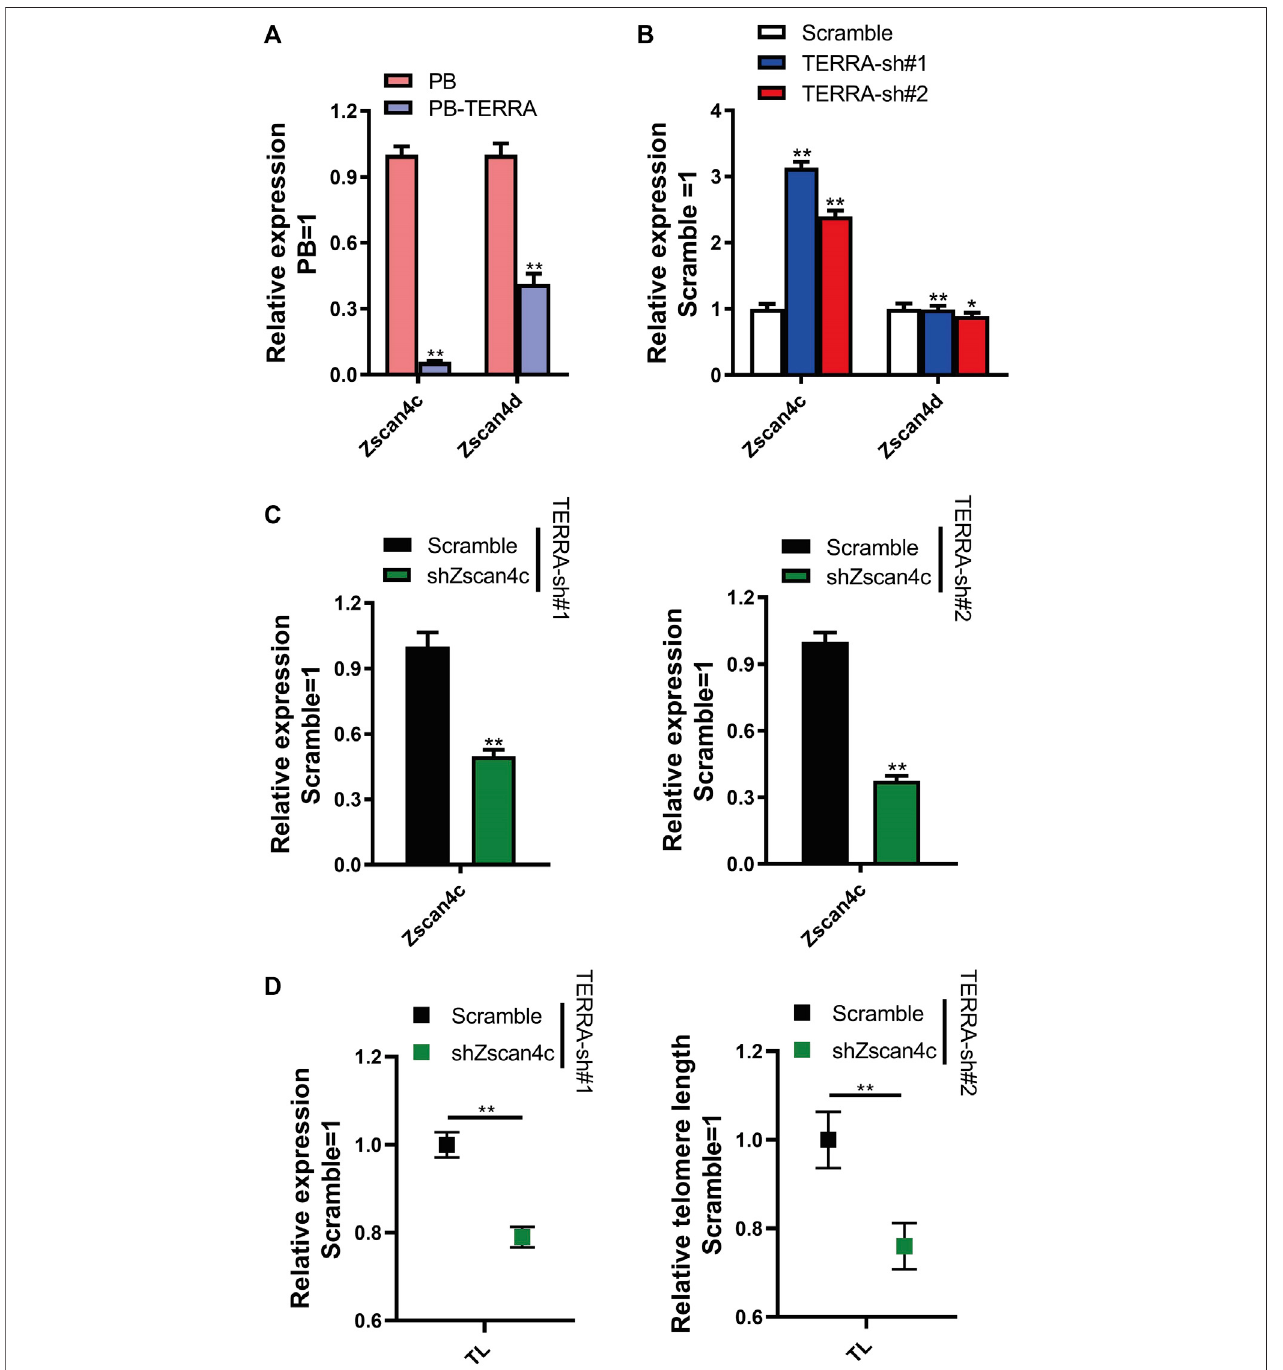
FIGURE 6 | Zscan4c is a primary target of polyadenylated TERRA and impairs telomere length. (A) Zscan4c and Zscan4d expression levels in PB and PB-TERRA 46C mESCs were analyzed by qRT-PCR. Data were normalized to PB cells. ** p < .01 vs. PB. (B) Gene expression analysis of Zscan4c and Zscan4d in TERRA shRNA 46CmESCs.DatawerenormalizedtoScramblecontrolcells.* p ＜ 0.05,** p ＜ 0.01vs.Scramblecontrol. (C) qRT-PCRanalysisofZscan4cexpressionlevelsinTERRA shRNA mESCs with Zscan4c knockdown. Transcript levels were normalized against Scramble shRNA control. ** p ＜ 0.01 vs. Scramble control. (D) qRT-PCR analysis of relative telomere length (TL) in TERRA knockdown mESCs carrying Zscan4c shRNA. ** p ＜ 0.01 vs. Scramble control. (A – D) Data represent means ± SD of three biological replicates.